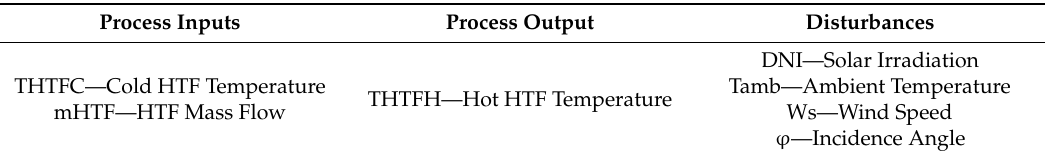
Table 1. Data organization. HTF: heat transfer